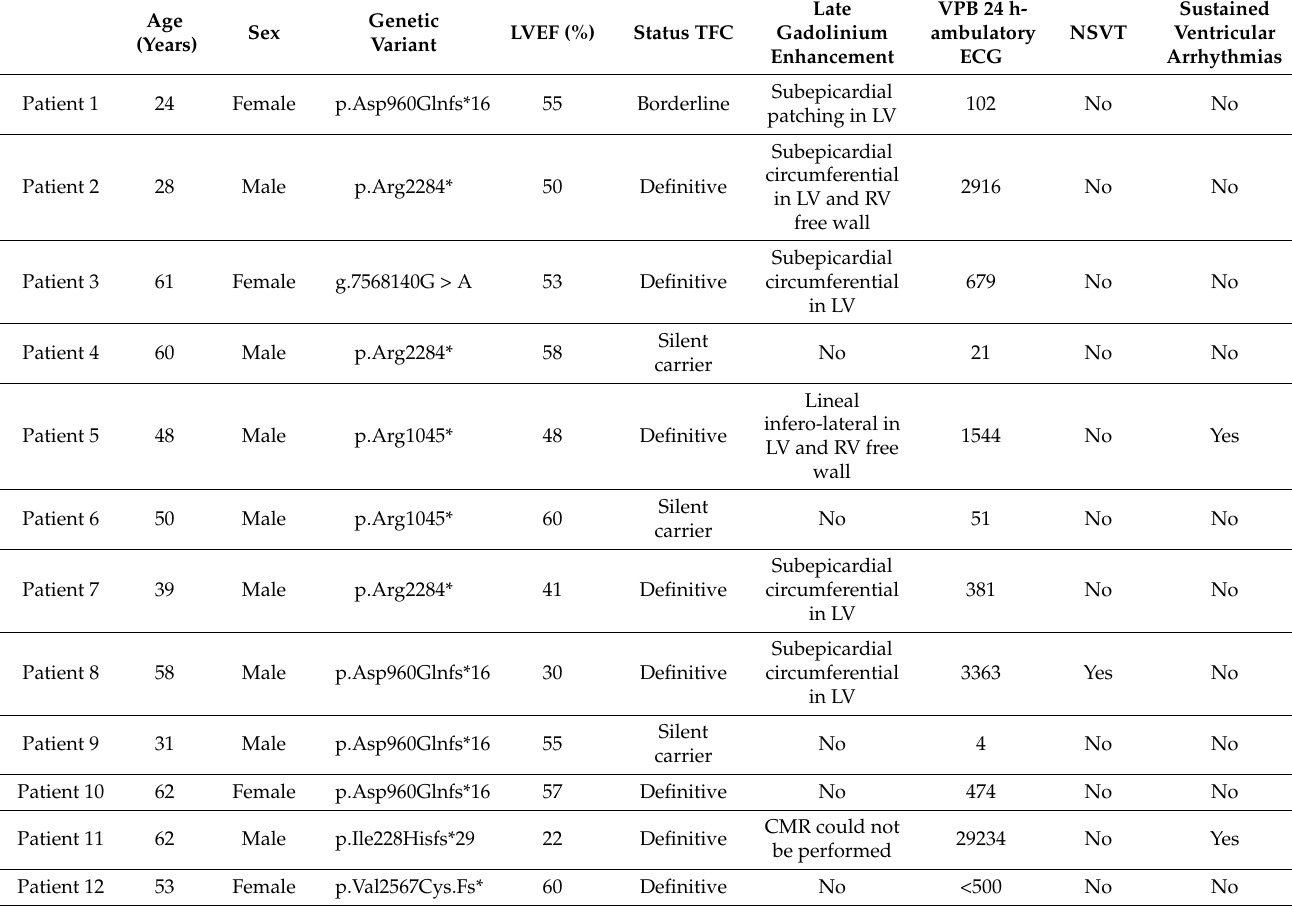
Table 1. Baseline cardiac